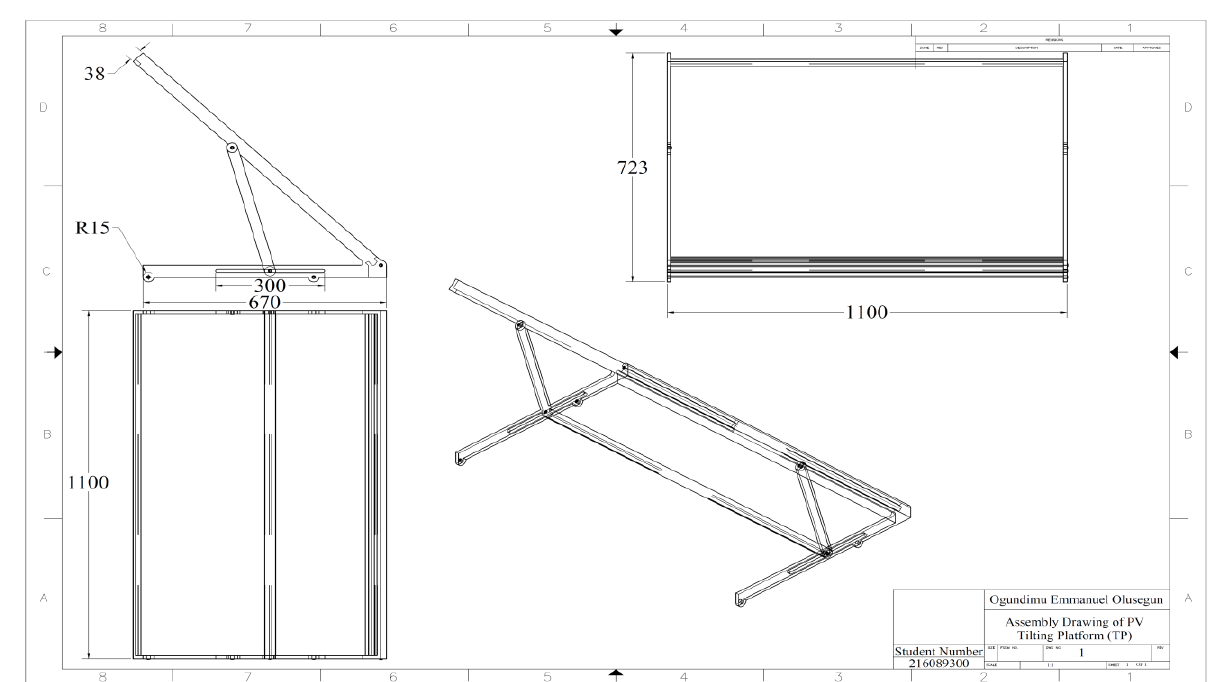
Figure 11: Assembly drawing of the proposed PV tilting